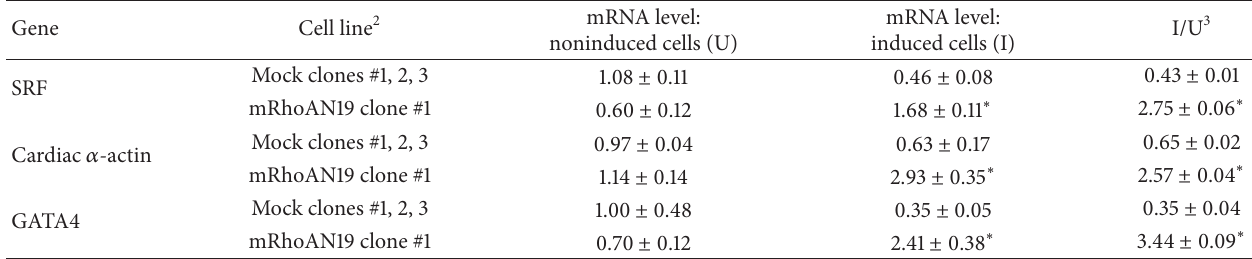
Table 2: mRNA levels of selected genes involved in heart development in P19CL6 cell lines with and without induction to generate a cardiomyocyte phenotype 1 .